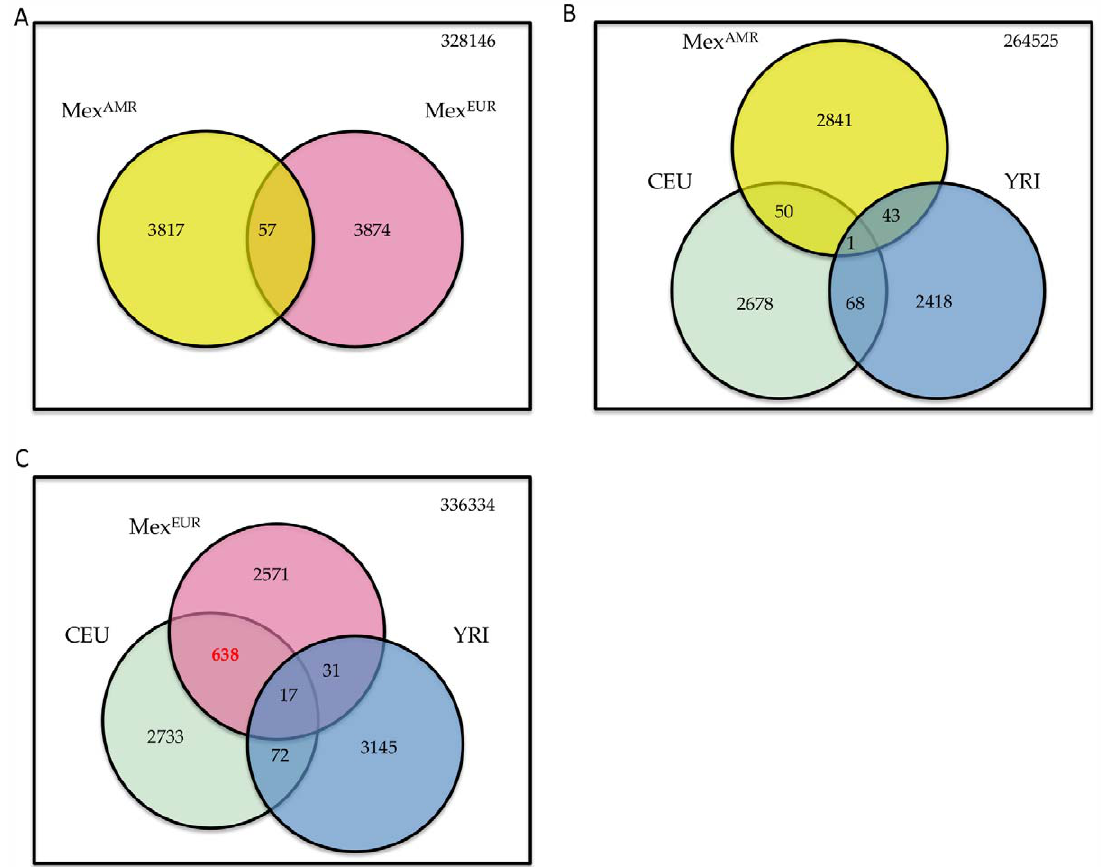
Figure 4. Signatures of recent positive selection. (A) Overlap of top 1% SNPs (with |iHS| . 2.5) in Mex EUR and Mex AMR . (B) Overlap of SNPs with |iHS| . 2.5 in Mex AMR , HapMap CEU and YRI [8]. (C) Overlap of SNPs with |iHS| . 2.5 in Mex EUR , HapMap CEU and YRI. Numbers in red denotes significant enrichment in overlap.